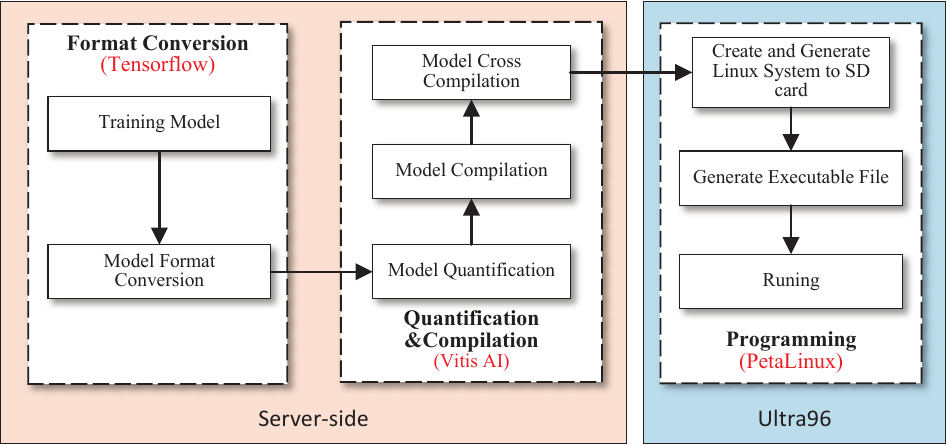
Figure 6. FPGA porting and deployment flow of the detection model of male and female litchi